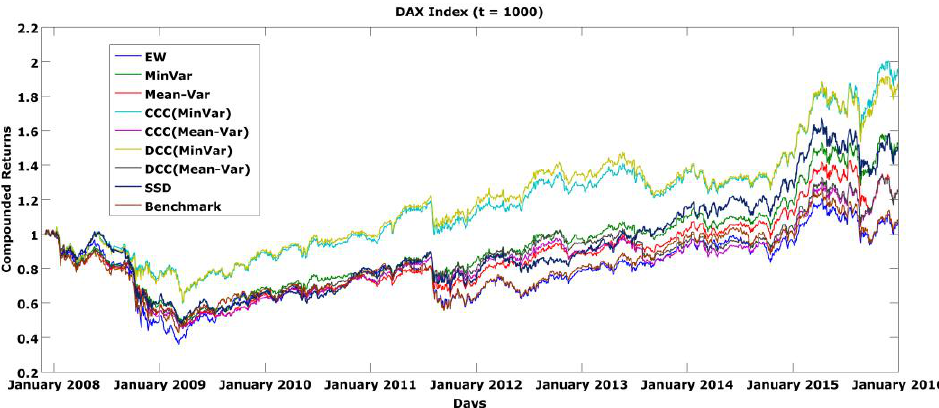
Figure 6. Compounded (on daily basis) returns of portfolios consisting of DAX stocks, t = 1000.